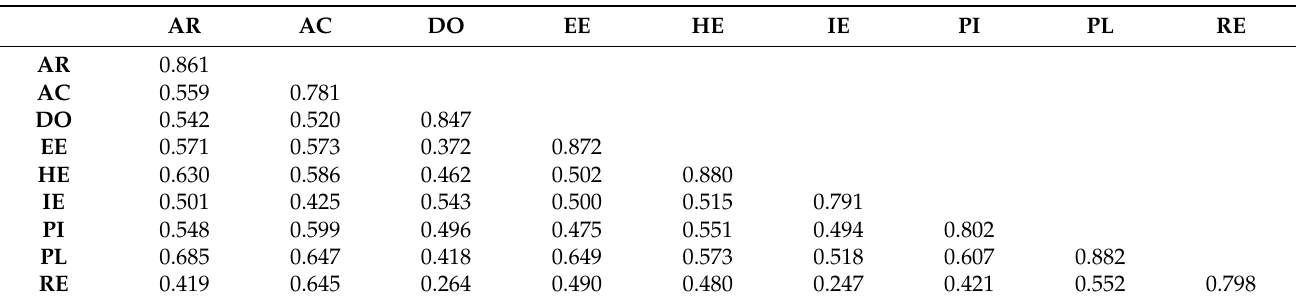
Table 5. Discriminant validity test.